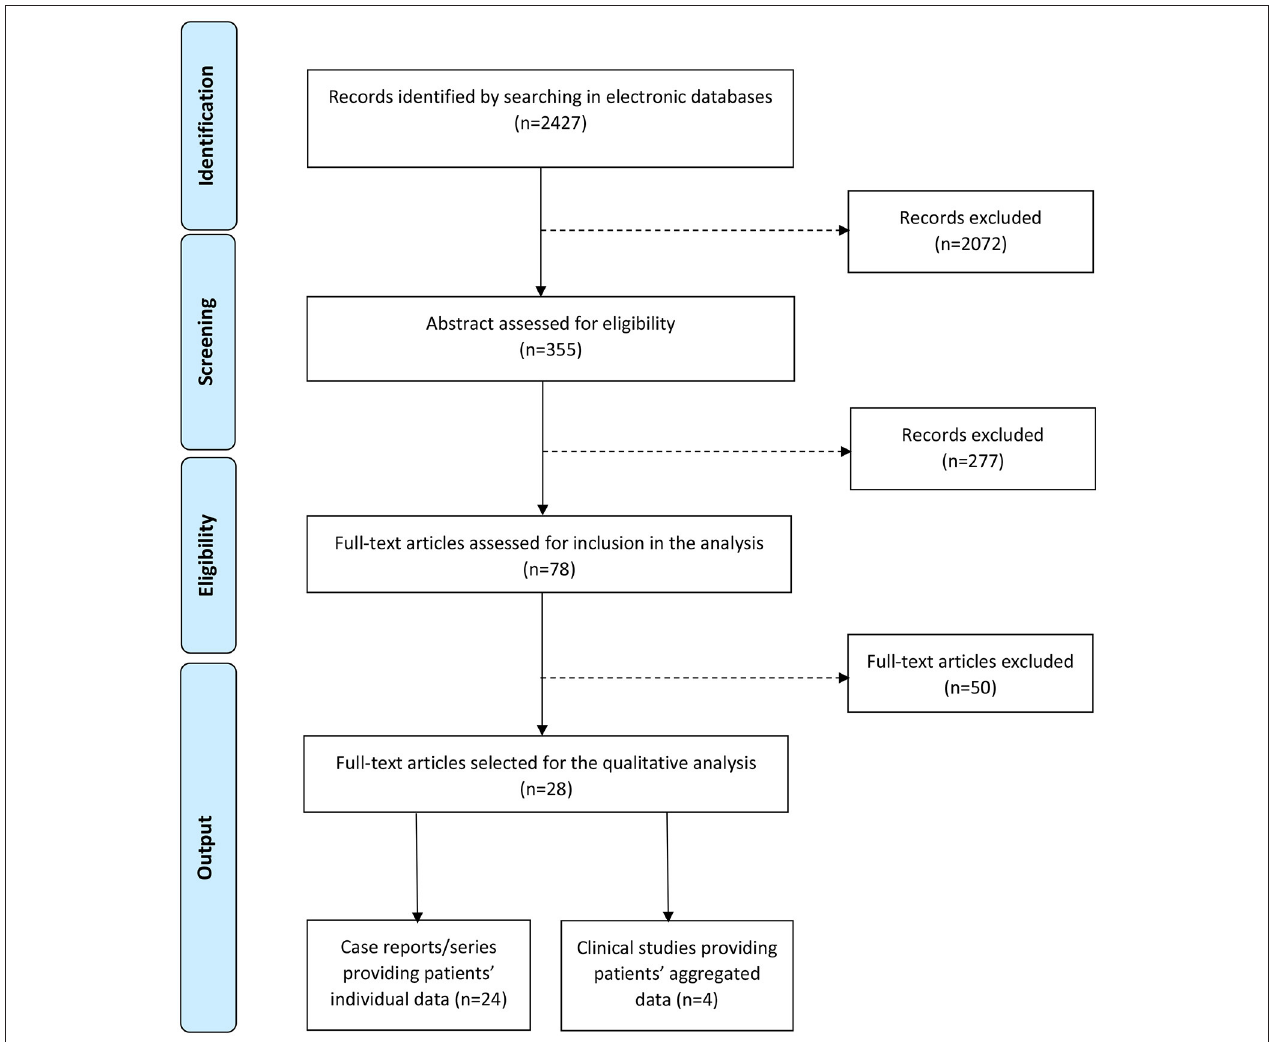
FIGURE 1 | PRISMA flow diagram of the systematic literature research.